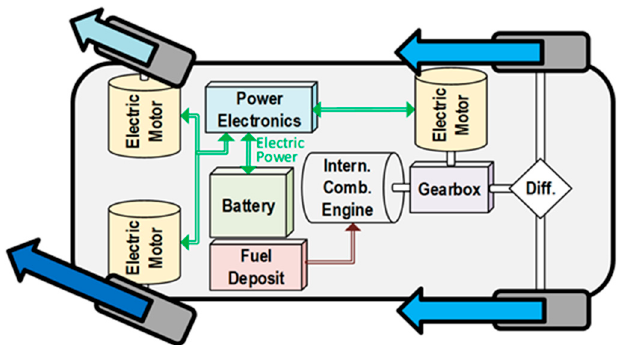
Figure 2. Diagram of the Honda/Accura NSX hybrid powertrain topology. Blue arrows indicate Torque-Vectoring algorithm applying different torque to wheels while driving a curve [3].